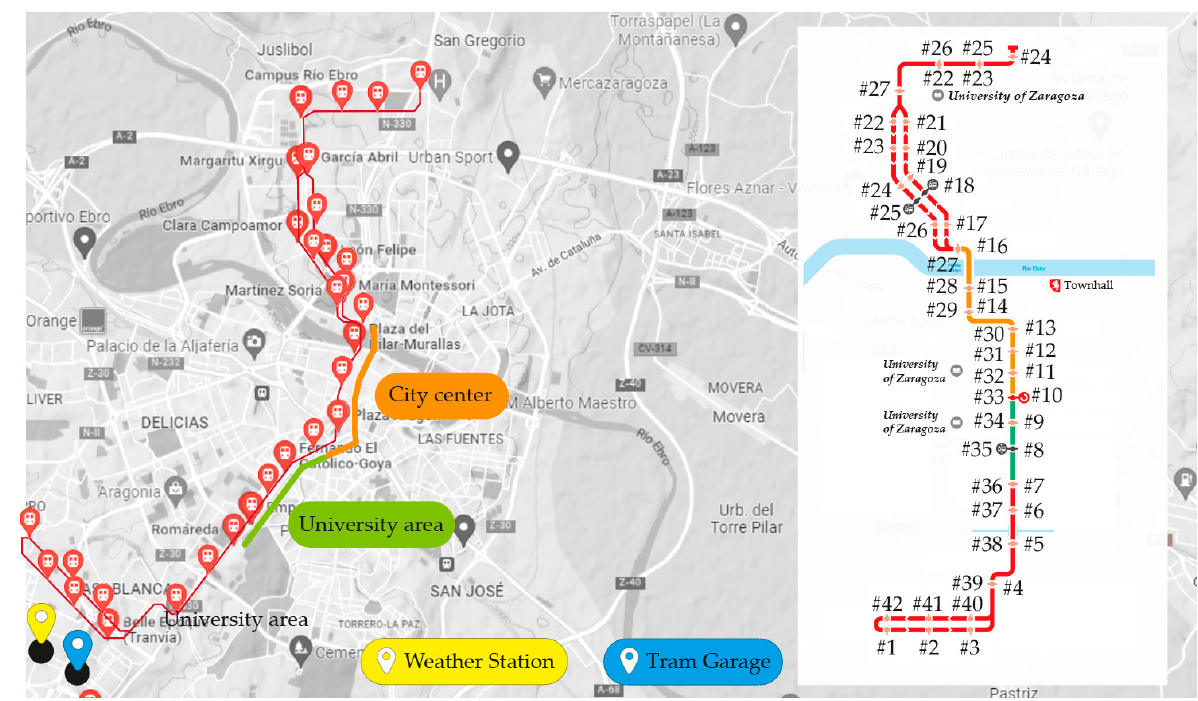
Figure 2. Route of the Zaragoza Tram. Where, # refers to the station ID.